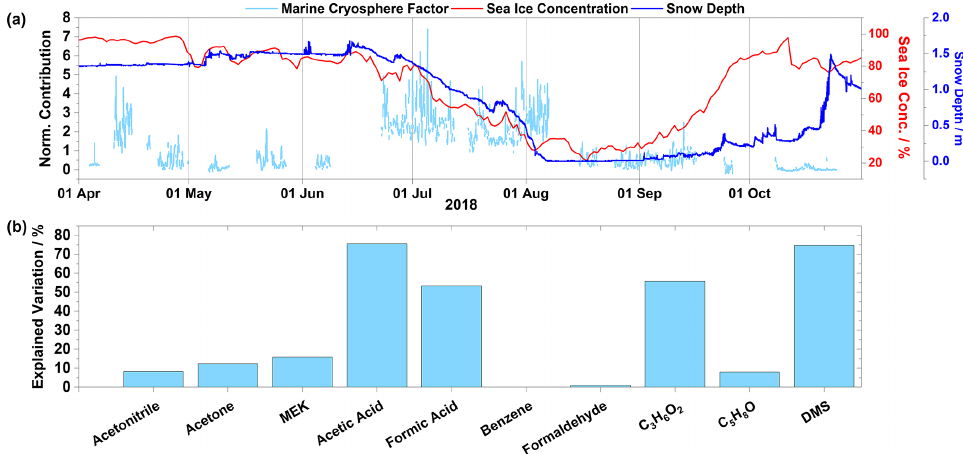
Figure 5. (a) Time series of normalized contributions in light blue (left axis), sea ice concentrations in red (right axis), and snow depth in blue (right axis). (b) Species profile for the marine cryosphere factor. Factor contributions are normalized to give a mean contribution of unity.